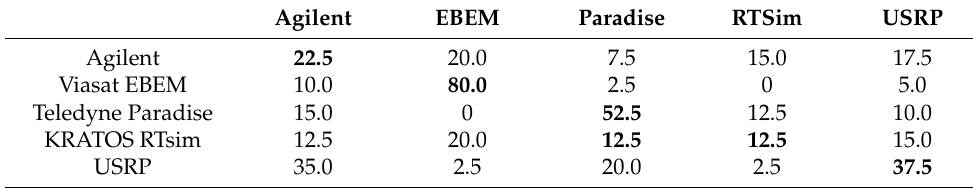
Table 4. Same as Table 3 @ SNR = 5